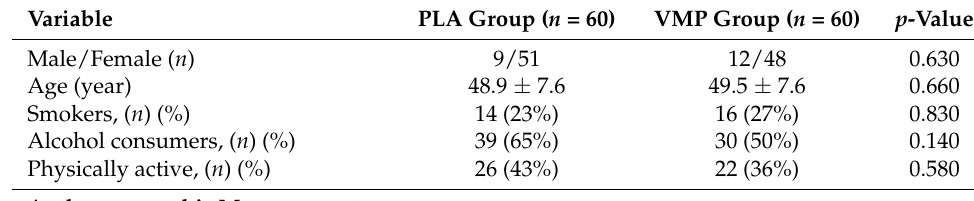
Table 3. Subjects baseline